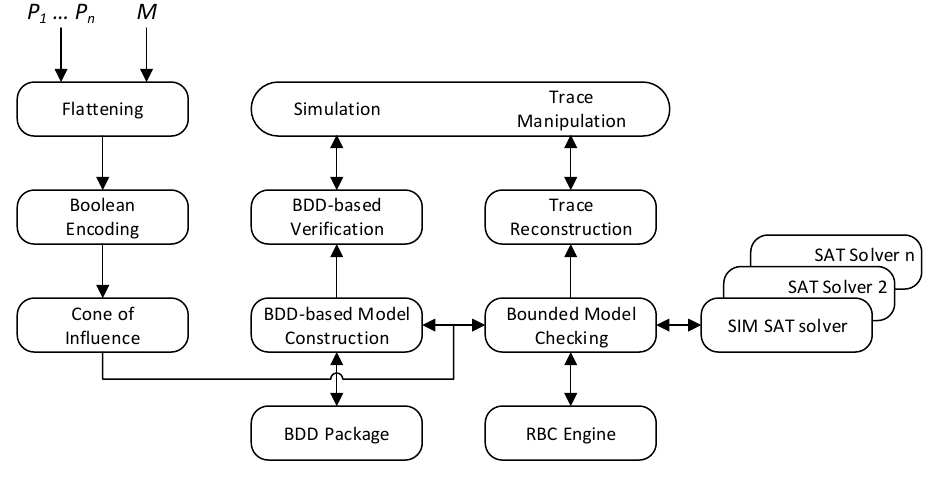
Figure 2. Steps performed by NuSMV2